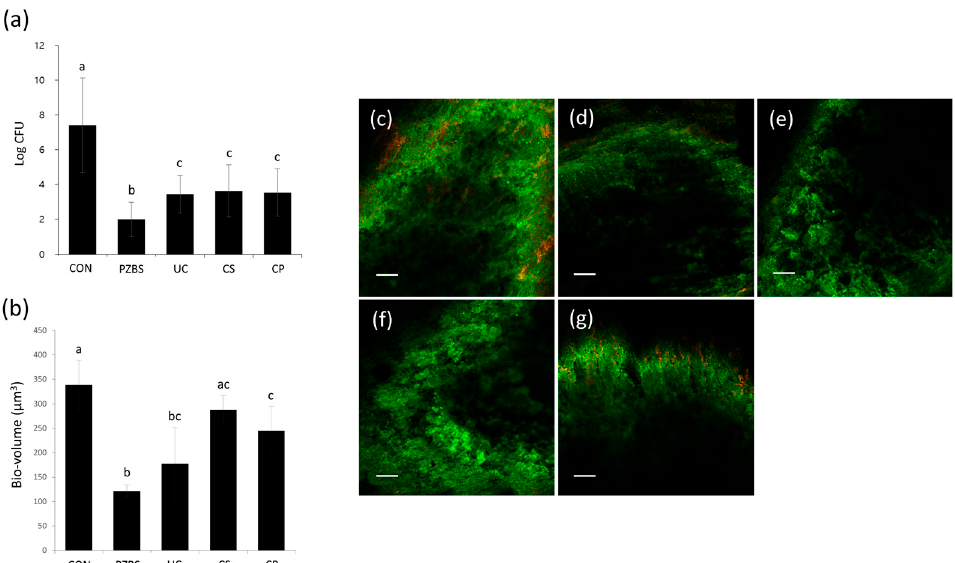
Figure 2. Antibacterial activity of PZBS and the tested intracanal medicaments: ( a ) Colony-forming unit counting. abc Dif- ferent letters represent significant differences between the different materials ( p < 0.05). ( b ) Determination of bio-volume through confocal laser scanning microscopic (CLSM) analysis. abc Different letters represent significant differences between the different materials ( p < 0.05). ( c – g ) Representative CLSM images of E. faecalis biofilms grown on specimens. Scale bar = 100 µ m. ( c ) CON; ( d ) PZBS; ( e ) UC; ( f ) CS; ( g ) CP. Different letters represent significant differences between the different materials ( p < 0.05). CON: control, PZBS: pozzolan-based bioceramic sealer, UC: Ultracal, CS: Calasept, CP: Calcipex II.